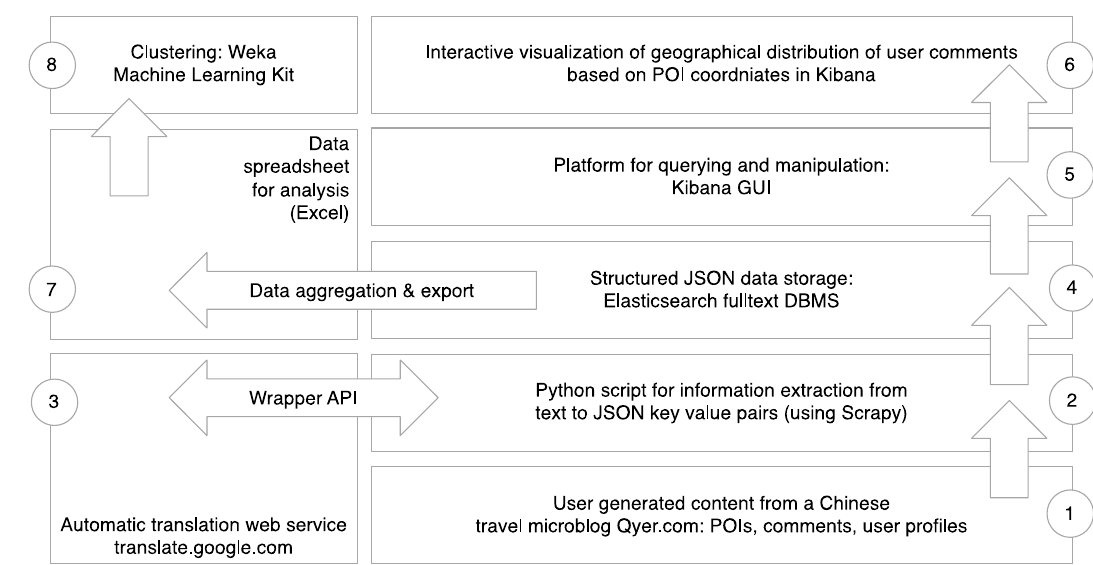
Figure 2. System architecture for data collection, consolidation and analysis.